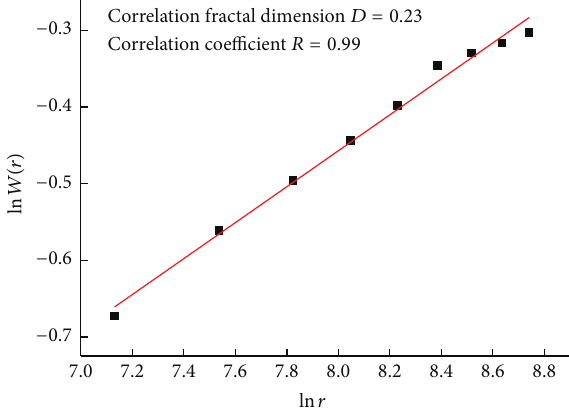
Figure 9: Calculation of CFD at stress level 40% under 800 ∘